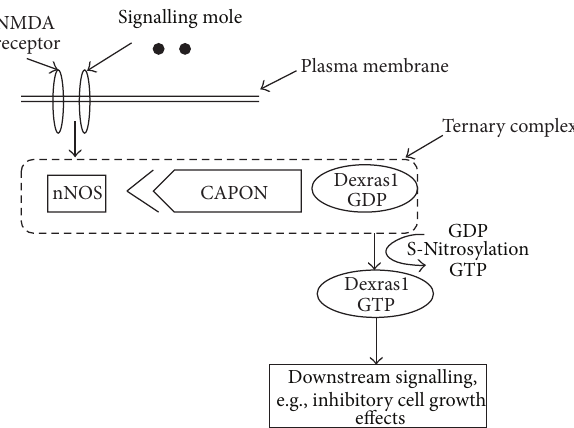
Figure 6: Dexras1 bound to GDP, nNOS, and CAPON can exist together as a ternary complex. NMDA receptors activation leads to S-Nitrosylation of Dexras1. S-Nitrosylation of Dexras1 leads to exchange of GDP with GTP and this active Dexras1-GTP initiates downstream